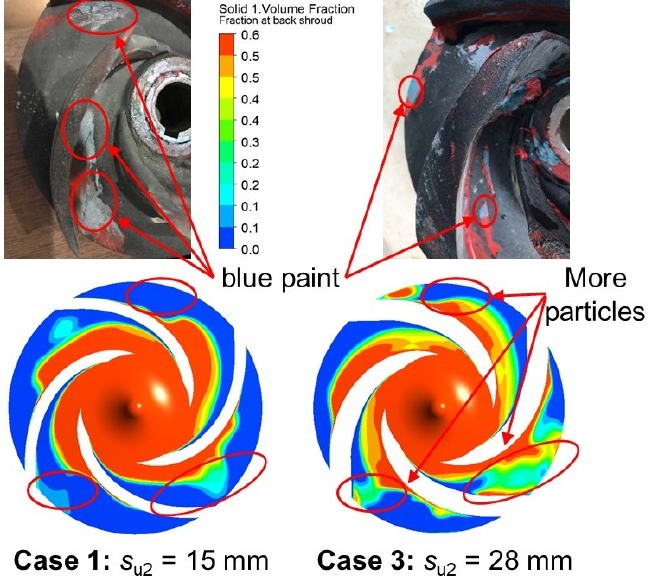
Figure 8. Comparison of the solid volume fractions and the wear patterns on the back shrouds of the tested impellers.